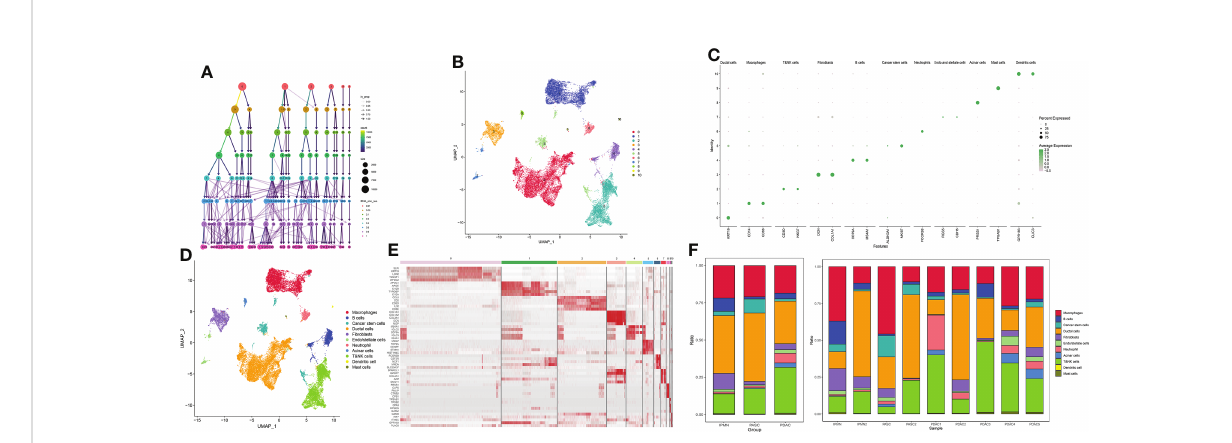
FIGURE 1 (A) Cluster tree of subgroup amounts at different resolution ratios. (B) UMAP cluster plot shows the divided subgroup before annotation. (C) Annotation of each subgroup with markers. (D) UMAP cluster plot shows the divided subgroup after annotation. (E) Heatmap shows the signi fi cantly expressed genes in each cluster. (F) Bar graph of the proportion of each identi fi ed subgroup in each sample or group. UMAP, Uniform Manifold Approximation and